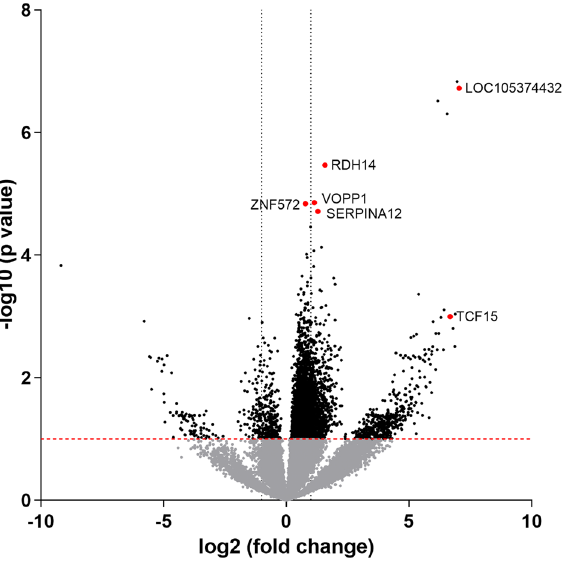
Figure 3. Volcano plot of sequencing data. Raw P-values in negative logarithmic scale on the y-axis as a function of the log2-fold change on the x-axis. Red dots represent the 6 upregulated candidate genes.